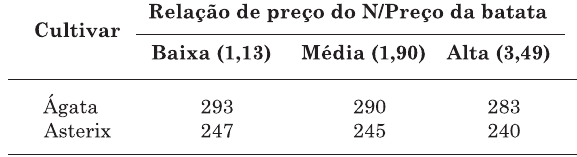
kg ha -1 , de tubérculos de batata cv. Ágata (a)